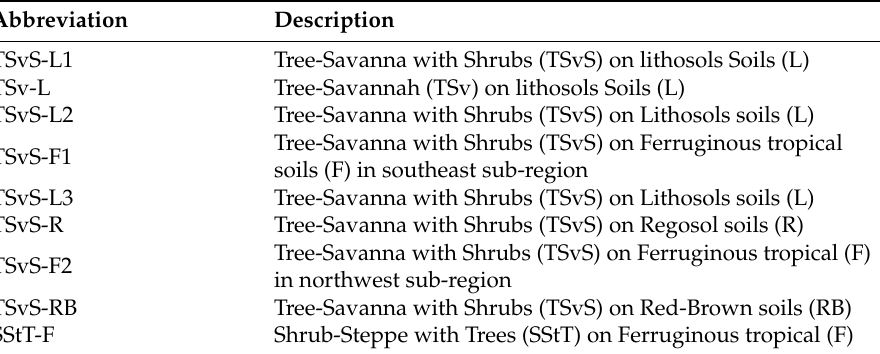
Table 3. Abbreviations for the different vegetation-soil zones (VSZ) obtained from combining maps of vegetation types and maps of soil